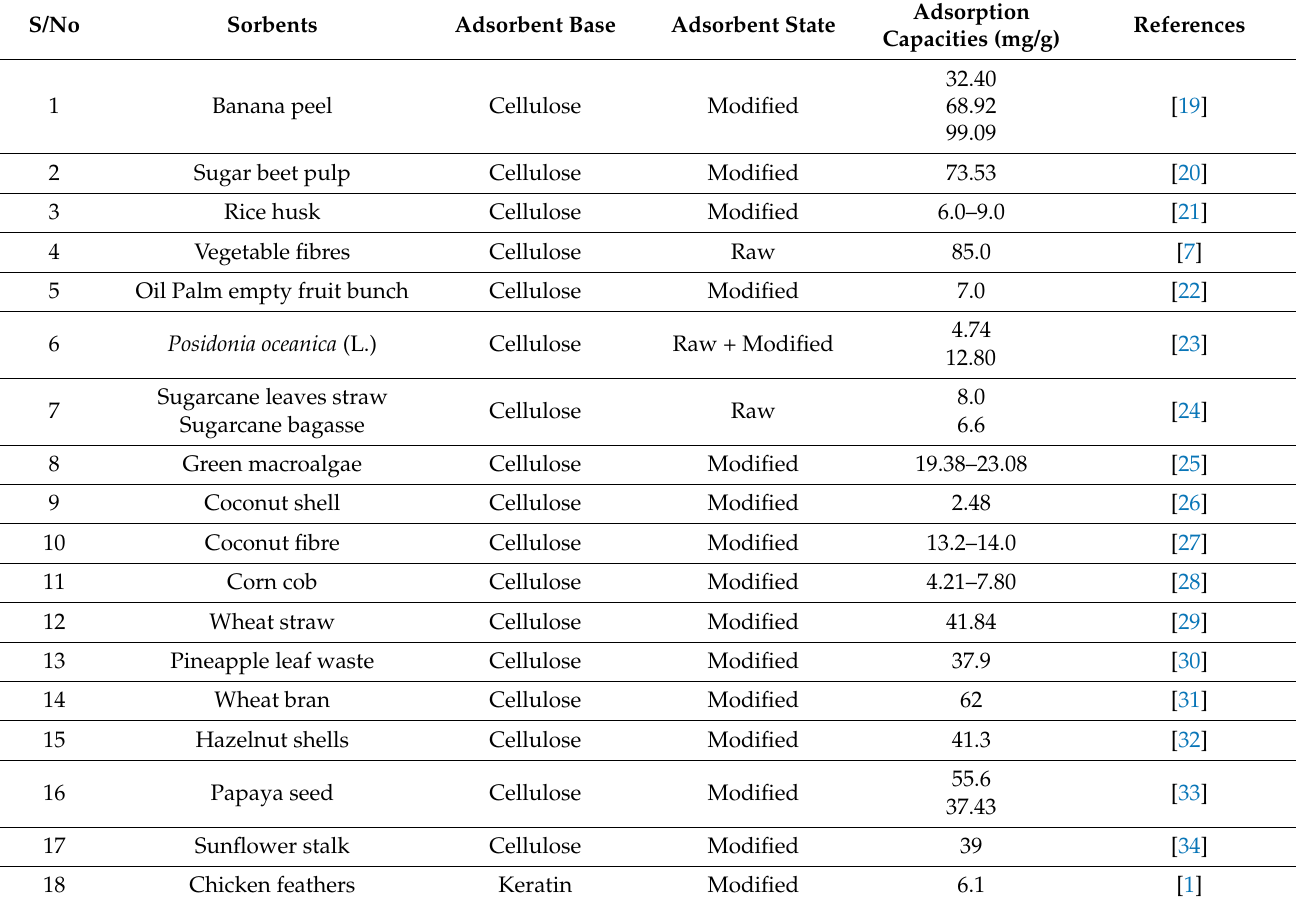
Table 1. Summary of studies on contaminants removal by natural organic